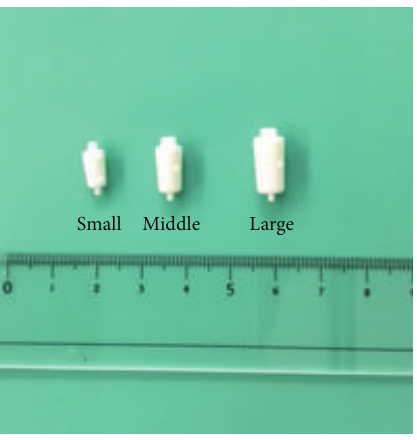
Figure 4: Three types of